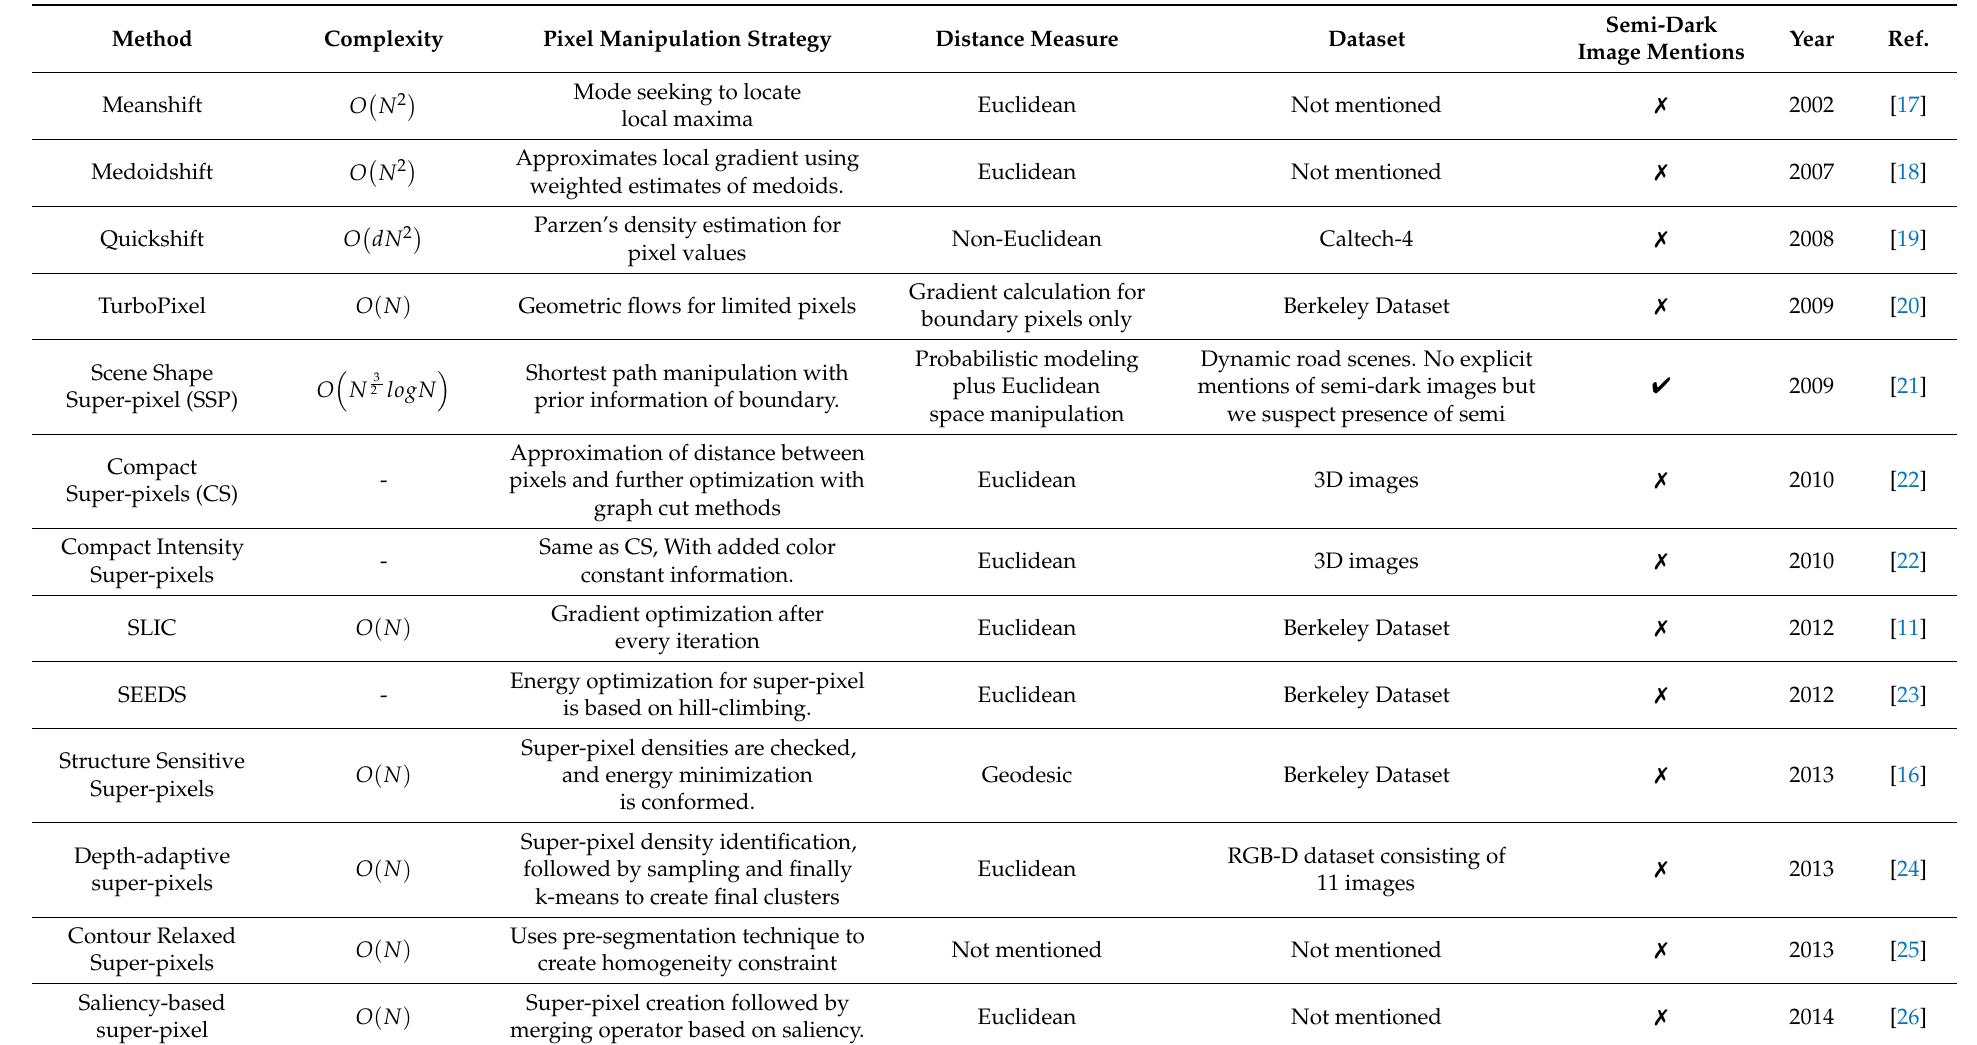
Table 1. Critical analysis of gradient-ascent super-pixel creation